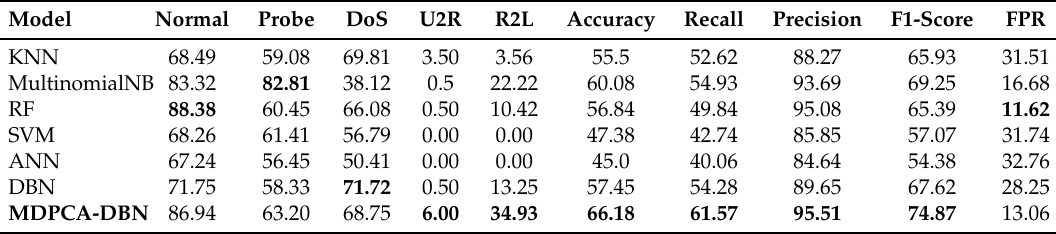
Table 11. Comparison results for the NSL-KDD (KDDTest-21) dataset (%).